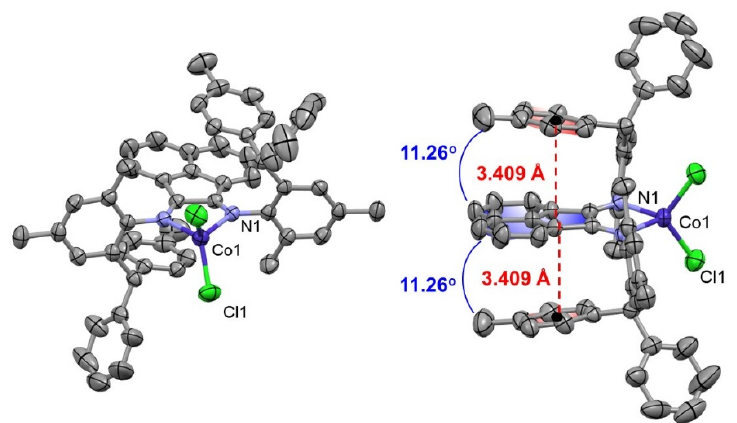
Figure 2. ORTEP drawing of complex Co1 with thermal displacement parameters at 50% probability. Bond lengths (Å): Co1-Cl1, 2.202(8), Co1-N1, 2.075(2), N1-C1, 1.279(3) N1-C8, 1.442(3). Bond angles (deg): Cl1-Co1-Cl1, 114.69(5), N1-Co1-Cl1, 117.29(6), N1-Co1-N1, 81.87(11), C1-N1-Co1, 110.81(16), C1-N1-C8, 121.26(19), C8-N1-Co1,